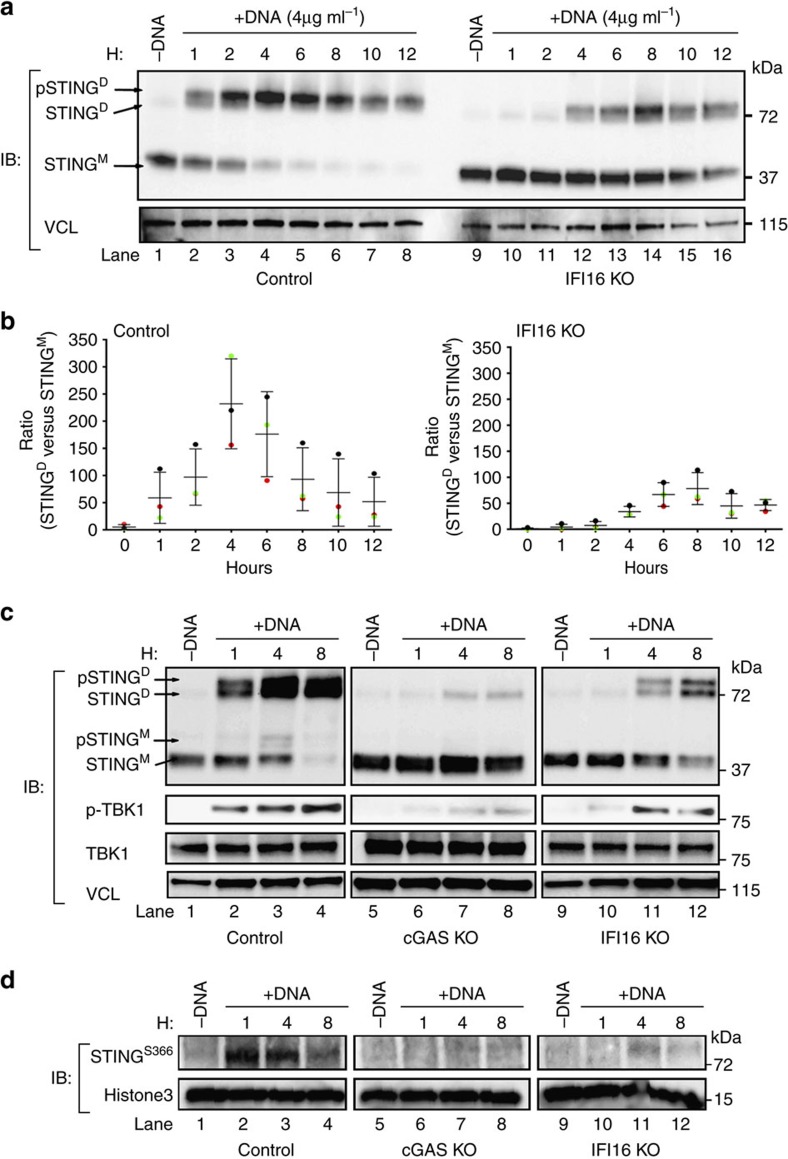
STING dimerization and phosphorylation is dependent on IFI16.(a,b) Control and IFI16 KO THP-1 cells were stimulated with dsDNA (4 μg ml−1) at indicated time-points and whole cell lysates were subjected to immunoblotting of STING dimerization by semi-native gel electrophoresis. Vinculin (VCL) was used as loading control. (b) The quantification of band intensity of STINGDimer versus STINGMonomor was done using ImageJ software of three independent experimental setups. (c,d) Control, cGAS KO and IFI16 KO cells were stimulated with dsDNA (4 μg ml−1) at indicated time-points and whole cell lysates were subjected to both semi-native gel electrophoresis and standard SDS–page. Membranes were probed with antibodies against STING, p-TBK1 and VCL (c) or phospho-specific STING Ser366 and Histone3 as loading control (d). Data presented in (a,c) are representative of at least three independent experiments, whereas data in (d) is representative of two independent experiments.